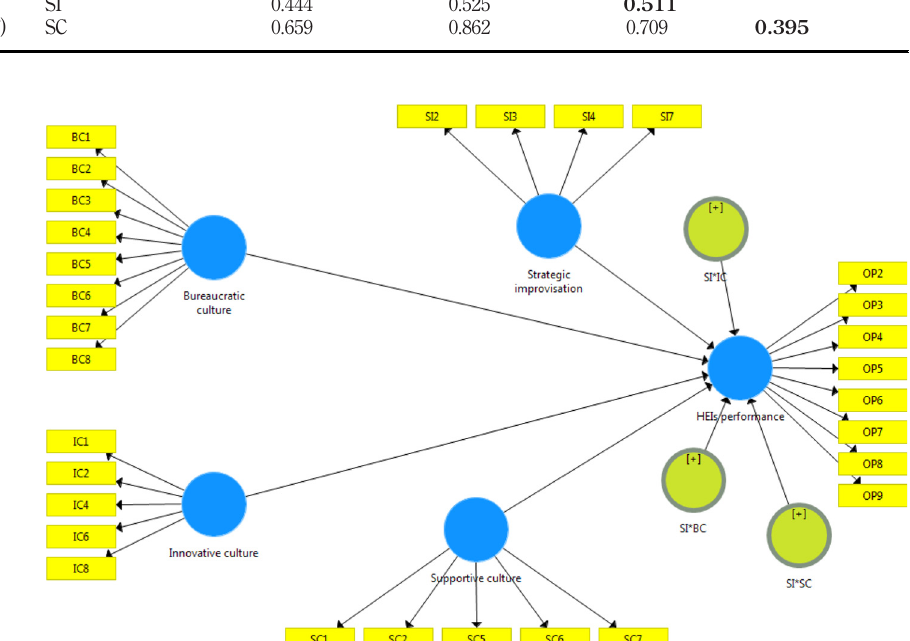
Figure 1. Research